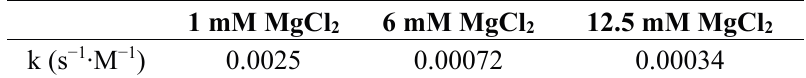
Table 2. Dissociation rate constants at different MgCl 2 concentrations.